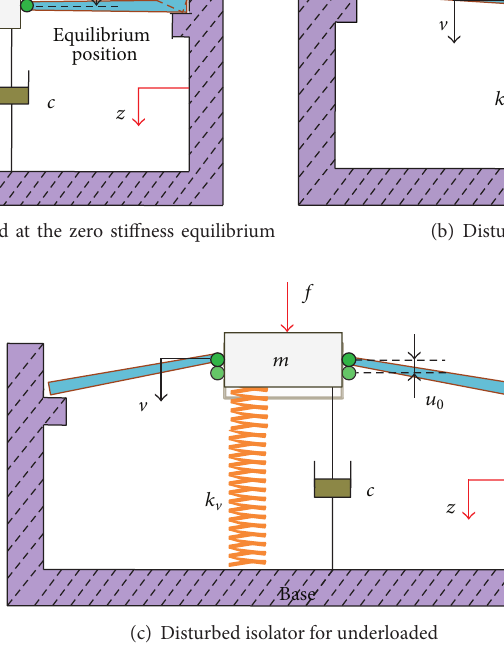
Figure 6: Schematic representation of the proposed QZS isolator.